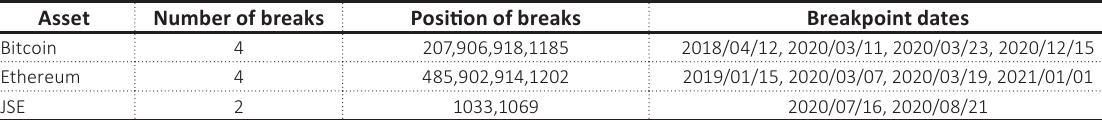
Table 5. Breakpoints identified in the return series